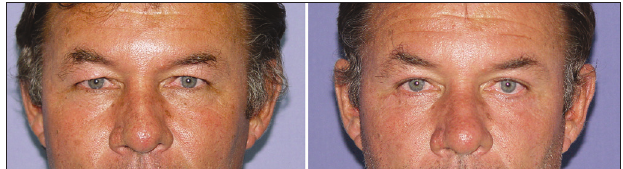
Figure 3. Patient with left lower eyelid malpositioning after blepharo- plasty caused by